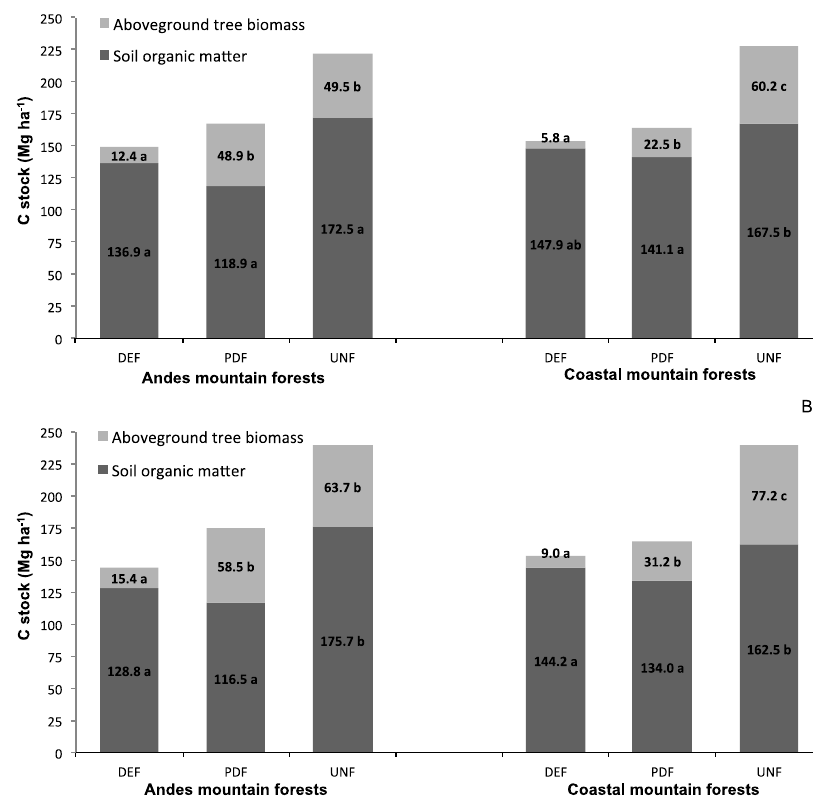
Figure 3. Change in C stocks of aboveground tree biomass and soil organic matter at 0–40 cm depth as influenced by change in Nothofagus forest condition (degraded (DEF), partly-degraded (PDF), and undisturbed (UNF) of the Andean and Coastal mountains of south central Chile in ( A ) 2013 and ( B ) 2015. Values with the same lower case letter among forest conditions within a same location and reservoir (tree biomass or SOM) are not significantly different (Student’s t test, * p < 0.05). Measurements were taken in September 2013 and